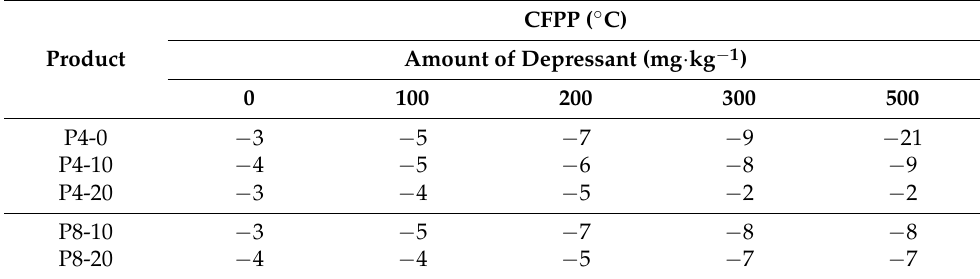
Table 6. Effect of the depressant on the CFPP of the products.